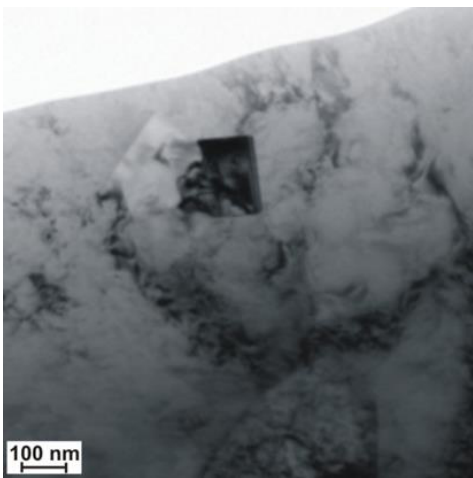
Figure 18. Precipitation of TiC carbide in the S700MC steel laser welded joint in the PC position with 5 kJ/cm linear energy.